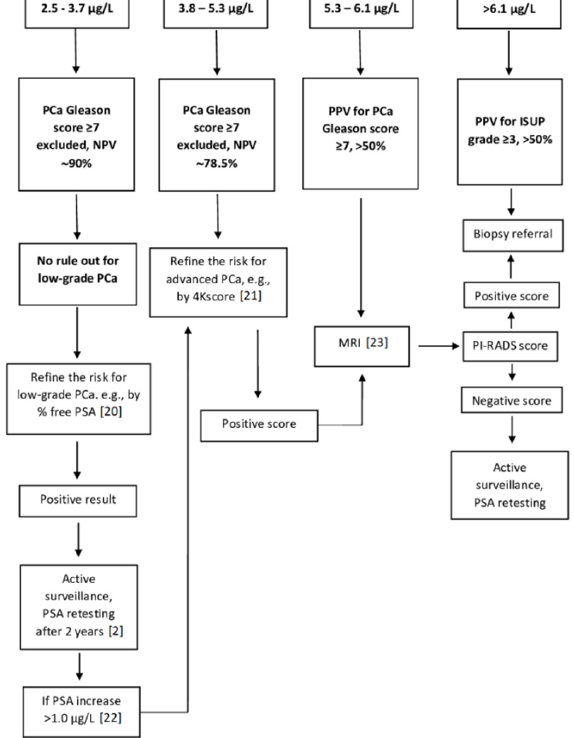
Figure 3. PSA—based diagnostic workup for patients ≥ 65 years old, asymptomatic for glandular inflammation, including recommendations on second level approaches inferred from the available literature (references reported in parentheses). The above values represent pre-biopsy serum PSA concentrations. In black, information derived by this study. Note: Recommended active surveillance implies PSA retesting after two years and it is stopped if the risk of advanced cancer increases according to an absolute PSA increase over 1 μ g/L. It is reasonable to endorse the PSA retesting interval recommended by the American Urological Association [2]. PCa, prostatic cancer; NPV, negative predictive value; ISUP, International Society of Urological Pathology; PPV, positive predictive value; 4Kscore, 4-kallikrein panel score; MRI, multiparametric magnetic resonance imaging; PD-RAS, Prostate Imaging-Reporting and Data